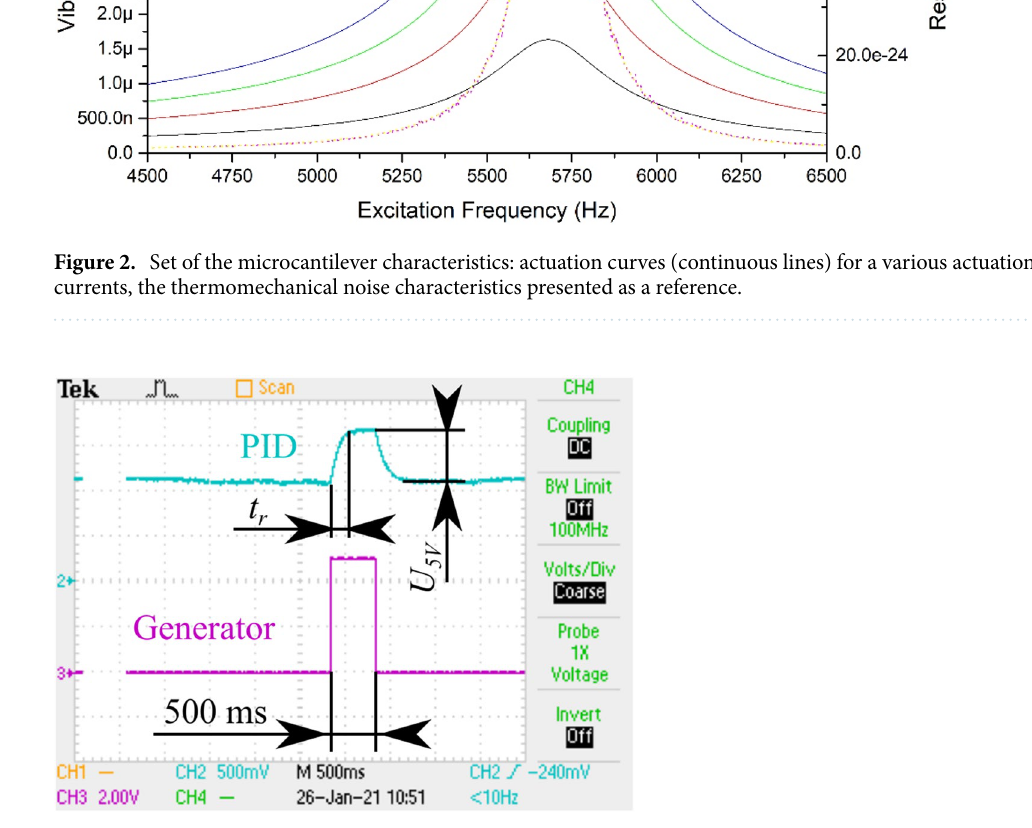
Figure 3. Control behavior of the electromagnetic microcantilever during PF